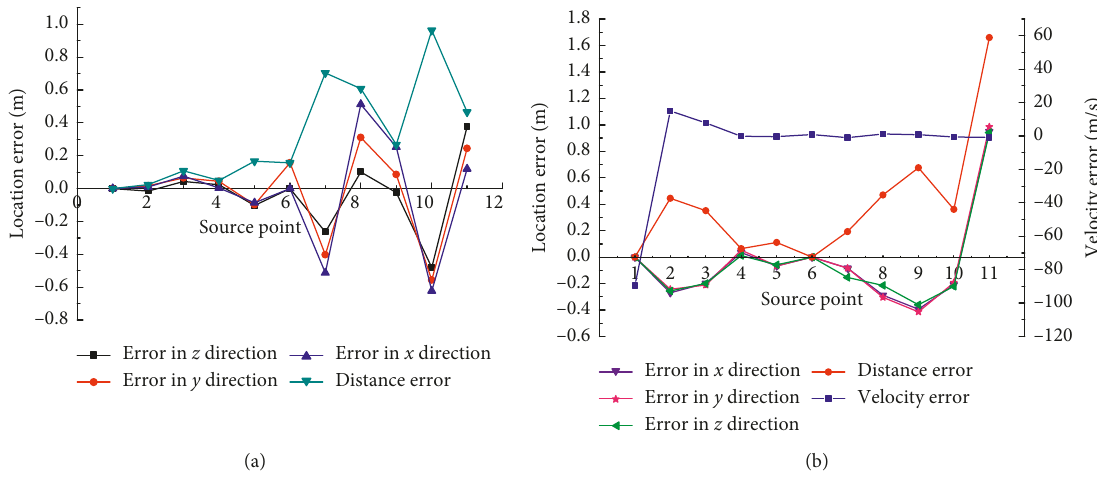
Figure 8: (a) Location error distribution under the known wave velocity. (b) Location error distribution under the unknown wave velocity.